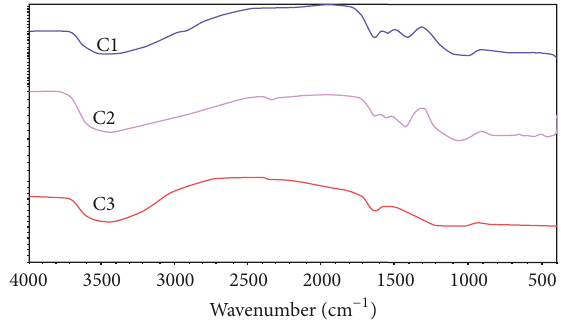
Figure 1: FTIR spectra of metakaolin zeolites (C1, 4 h, 3 M NaOH zeolite; C2, 4 h, 5M NaOH zeolite; and C3, 4h, 1M NaOH zeolite).